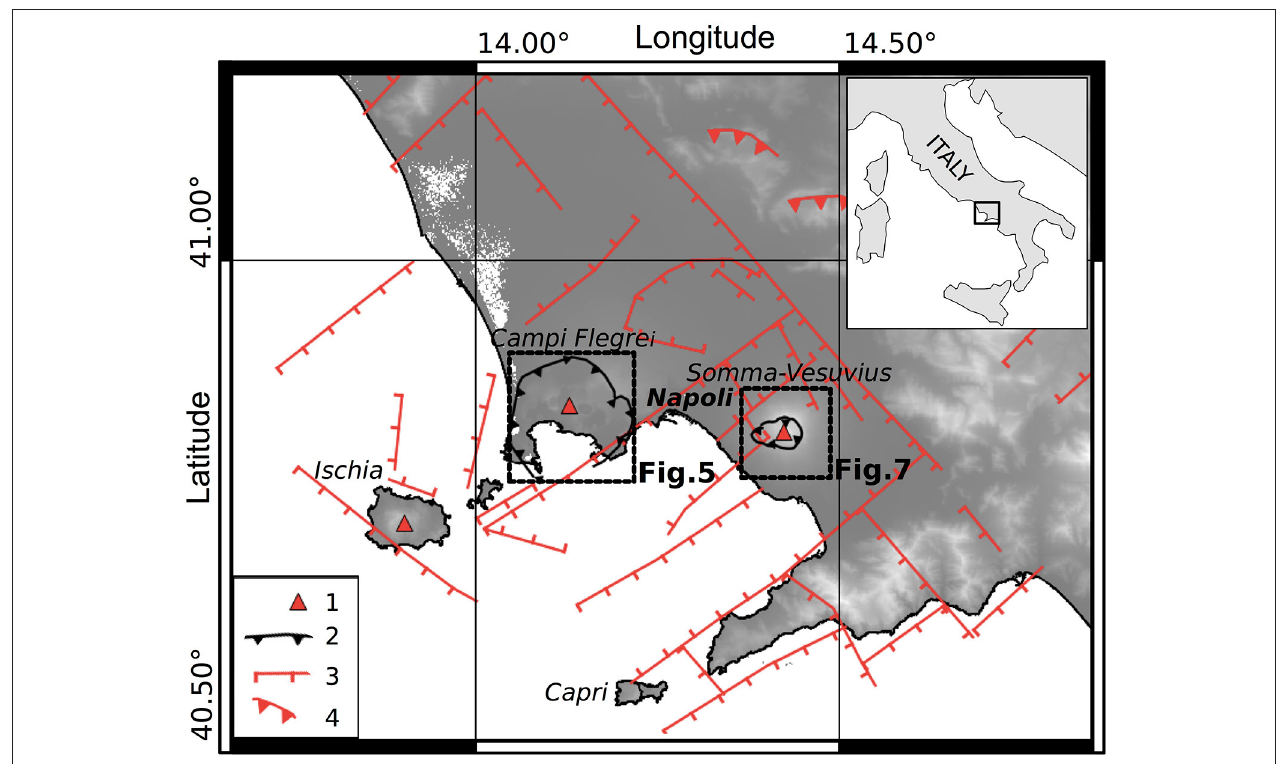
FIGURE 4 | Tectonic setting of the Campi Flegrei-Vesuvius area. (1) Main volcanoes; (2) Campi Flegrei (Campanian Ignimbrite) and Mt. Somma caldera rims; (3) main Plio-Quaternary faults; (4) thrust faults. Dashed squares identify the location of Figures 5 , 7 . Data from: Ippolito et al., 1973; Di Vito et al., 1999; Lavecchia et al., 2003; Acocella and Funiciello, 2006; Milia et al., 2013; Vitale and Isaia, 2013; D’Auria et al., 2014a,b, and referencer therein.